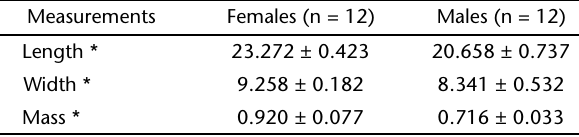
Table III. Mean and standard deviation of the length, in mm, and the mass, in g, of the pupae of M. cruenta , grouped by gender. Larvae were fed mate tea, and maintained under 25 ± 1ºC temperature; 70 ± 10% relative humidity and 14 hours of